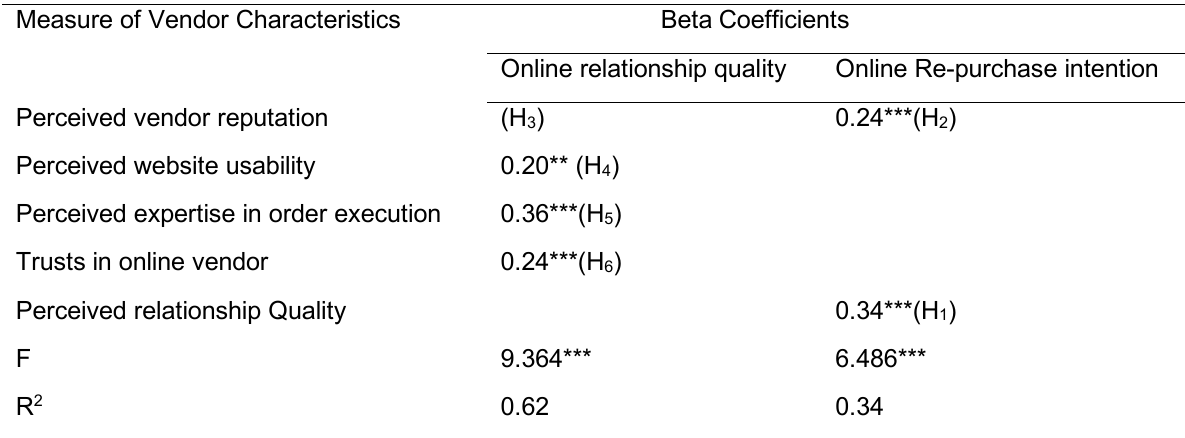
Table 2: Multiple regression